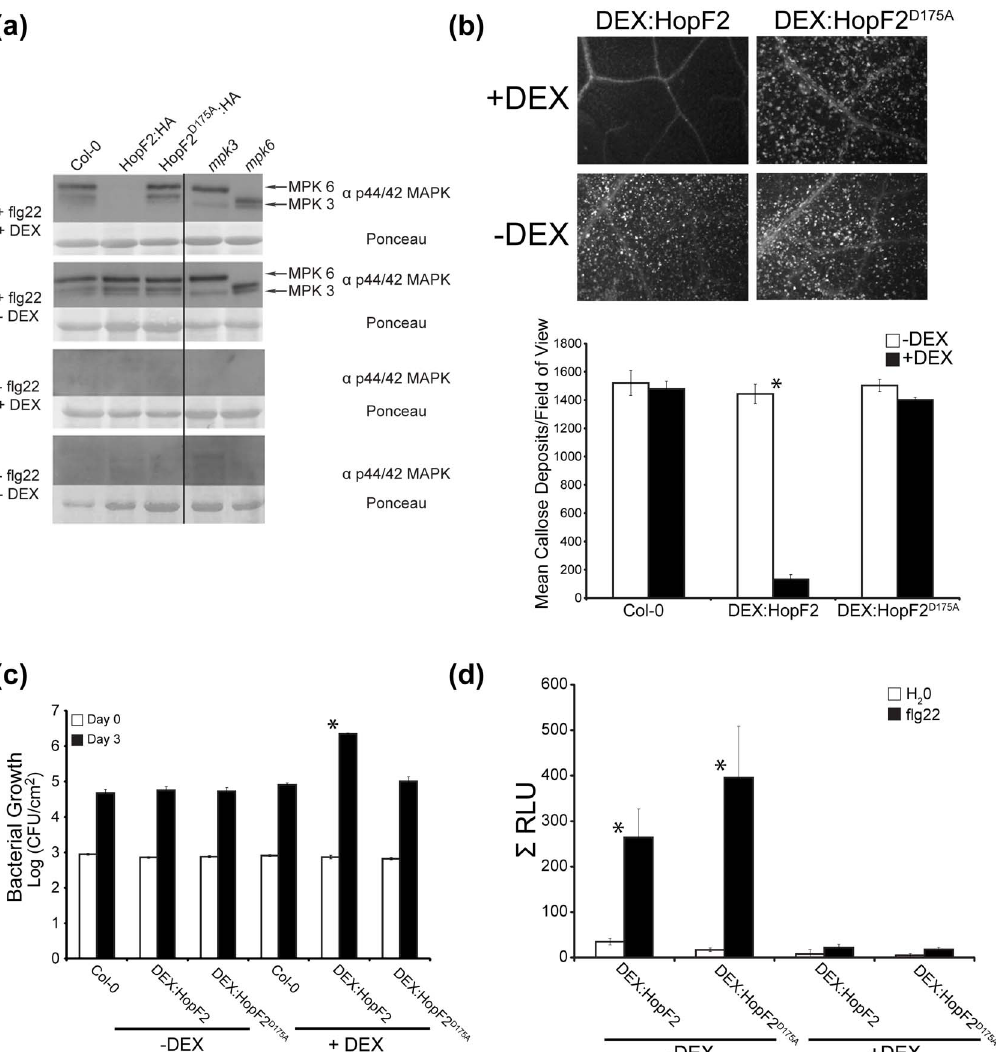
Fig. 5. HopF2 inhibits PTI through distinct molecular mechanisms. (a) Transgenic expression of HopF2 subverts MAP kinase activation in Arabidopsis. Eleven-day-old seedlings of Col-0, transgenic Arabidopsis expressing HopF2 and mutant Arabidopsis lacking mpk3 or mpk6 were incubated with 3 m M DEX ( + DEX) or water (–DEX) 24 h prior to treatment with 1 m M flg22 ( + flg22) or water. Samples were collected 20 min after treatment with flg22 (see Methods). Activated MAPKs were detected by immunoblotting using anti-p44/42 MAPK antibody. Mutant Arabidopsis lacking mpk3 or mpk6 represent negative controls for the respective MAPK bands. Ponceau staining is presented as a loading control. Results are representative of 5 independent replicates. (b) Transgenic expression of HopF2 inhibits callose deposition triggered by infiltration of Pto DC3000 D hrcC . Four week old Col-0 or transgenic Arabidopsis expressing HopF2 were sprayed with 30 m M DEX ( + DEX) or water (–DEX) 24 h prior to inoculation. Leaves were stained with aniline blue and visualized 24 h after inoculation of 1 6 10 8 cfu/mL of Pto DC3000 D hrcC . Callose deposition was quantified using Image J by counting number of papillae in 12 field of views per treatment. Values are means ¡ SEM from n 5 12 leaves. Asterisk denotes statistically significant differences between DEX treatment samples as determined by a pairwise Student’s t-test (P , 0.05). Results are representative of 3 independent replicates. (c) Transgenic expression of HopF2 increases growth of syringe inoculated Pto DC3000 D hrcC. Four week old Col-0 or transgenic Arabidopsis expressing HopF2 were treated with 30 m M DEX ( + DEX) or water (–DEX) immediately after bacterial inoculation (1 6 10 5 cfu/ml). Bacterial counts were performed 1 h after inoculation (day 0; filled bars) or 3 days postinoculation (day 3; open bars). Values are means ¡ SEM from n 5 12 leaves. Asterisk denotes statistically significant differences between day 3 samples as determined by a pairwise Student’s t-test (p , 0.05). Results are representative of 3 independent replicates. (d) Transgenic expression of HopF2 inhibits flg22 triggered ROS production. Four week old transgenic Arabidopsis expressing HopF2 were sprayed with 30 m M DEX ( + DEX) or water (–DEX) 24 h prior to inoculation and leaf discs floated in 2 m M flg22. ROS production was quantified using luminol and horseradish peroxidase with luminescence recorded every two minutes for 60 min. Values are mean sums of total luminescence ¡ SEM from from n 5 6 wells. Asterisk denotes statistically significant differences between DEX treatment samples as determined by a pairwise Student’s t-test (P , 0.05).